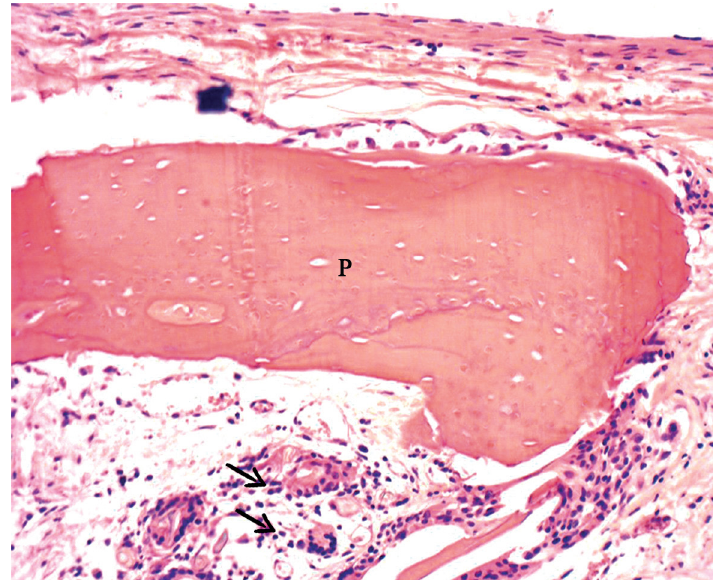
Figure 5- Group AB+PBMT: Presence of particle (P) in central surgical defect and some giant cells (arrows) (20x)